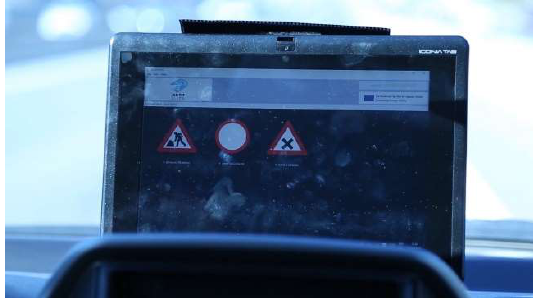
Figure 3. Human Machine Interface for the C-ITS driver warning messages.